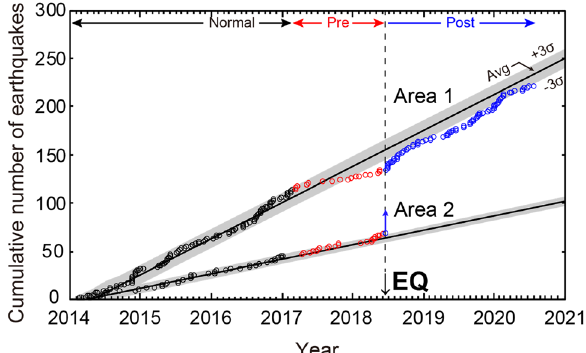
Figure 2. Cumulative earthquake ( M j > 1.0) numbers in the epicentral region of the 2018 Northern Osaka earthquake. The regression line was drawn with the data (open black circles) in the normal period, and the standard deviation (σ) of the vertical fluctuation of the value with respect to the regression line was obtained. The area between + 3σ and − 3σ is shown in the grey area. Areas 1 and 2 are shown in Fig.